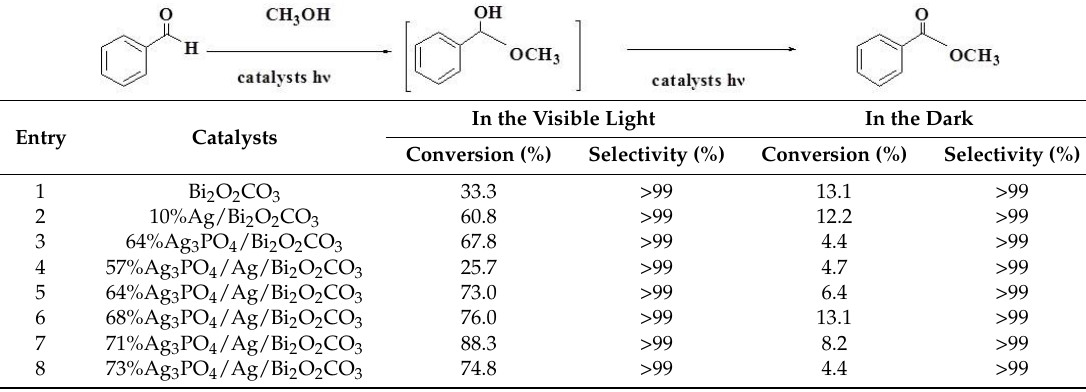
Table 2. Synthesis of esters from benzaldehyde and methanol using different photo-catalysts.